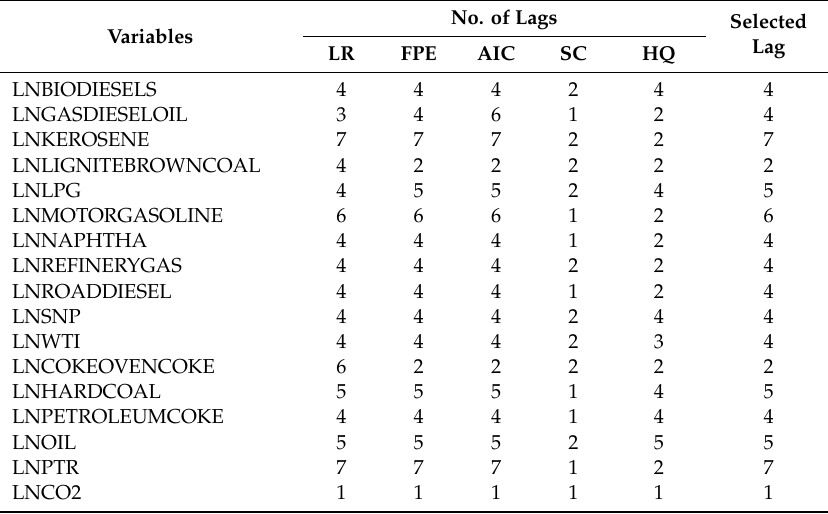
Table 6. Choosing the number of